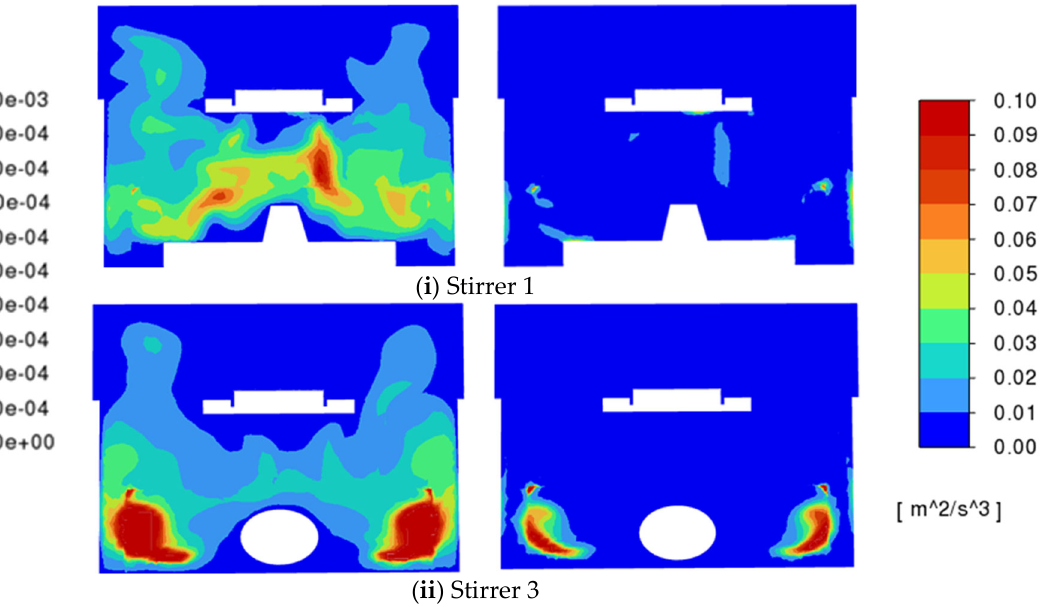
Figure 9. Turbulence kinetic energy ( left ) and turbulence energy dissipation rate ( right ) for stirrers 1 and 3 operating at 200 rpm.